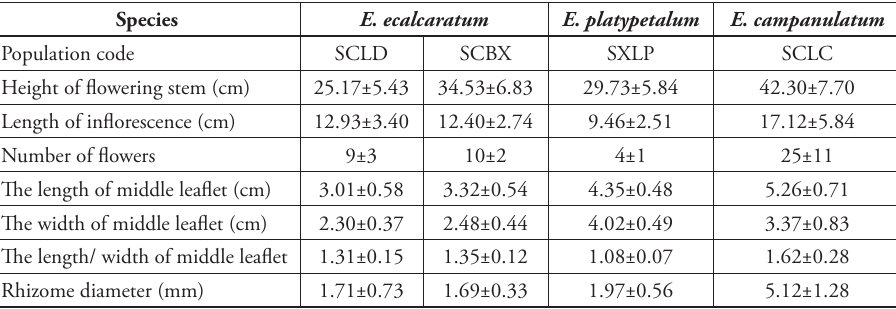
Table 2. Quantitative traits (mean ± SD) comparative analysis of populations of E. ecalcaratum , E. platy- petalum , and E. campanulatum